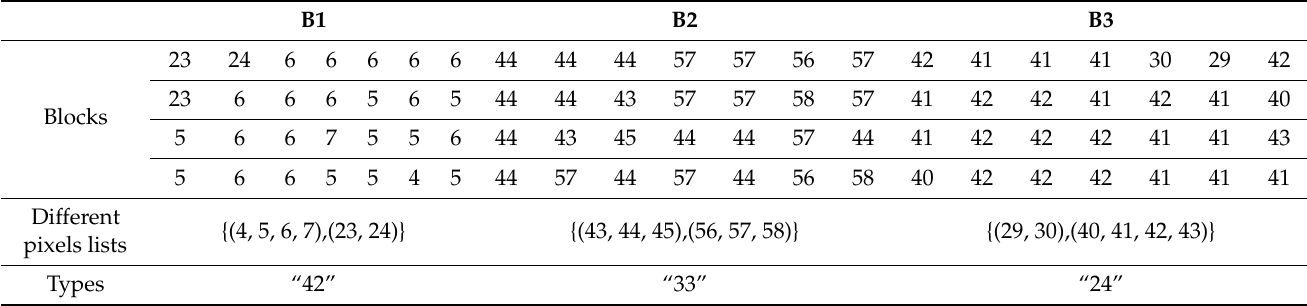
Table 3. Unreversible example for cases where the number of different pixels inside a block is